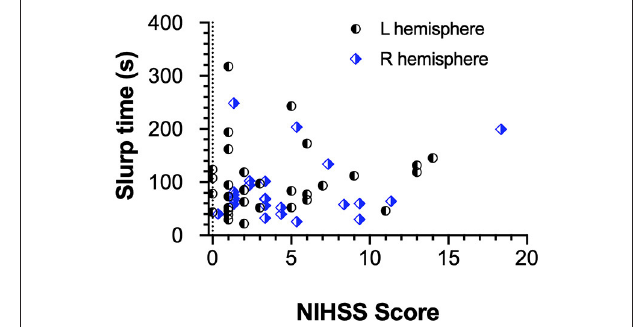
FIGURE 4 | EHC Time as a function of NIHSS Score and Hemisphere of lesion. The scatter plot shows a poor correlation between both parameters regardless of the affected